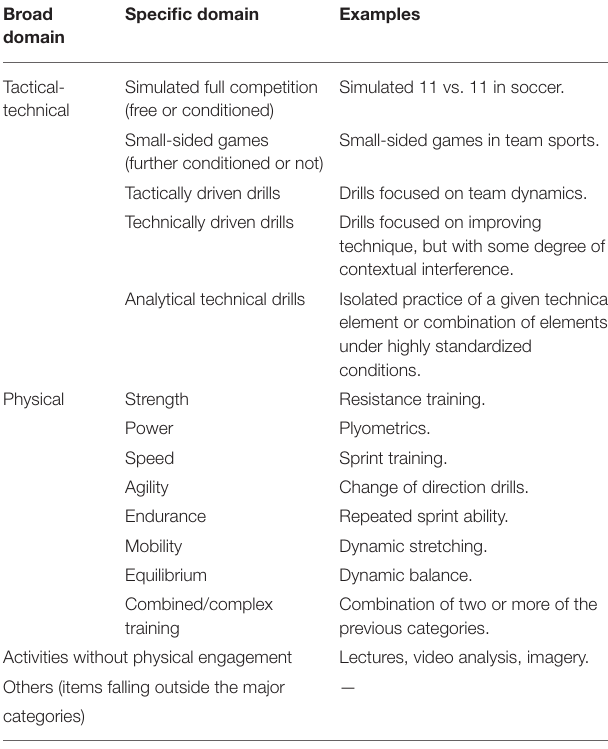
TABLE 1 | Model for categorizing load orientation according to main focus a,b . Broad